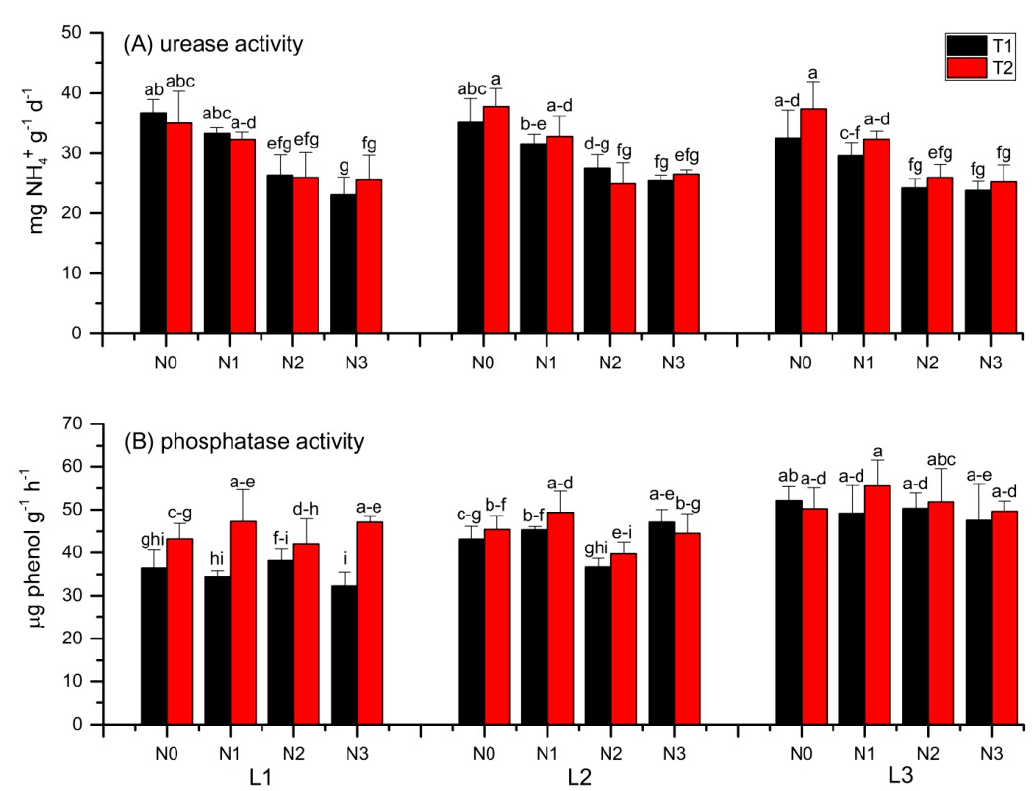
Figure 4. The activities of soil urease ( A ) and phosphatase ( B ) in different treatments. Error bars represent the standard error of the means ( n = 3). Bars with different letters lowercase are significantly different according to the Duncan test at p < 0.05.